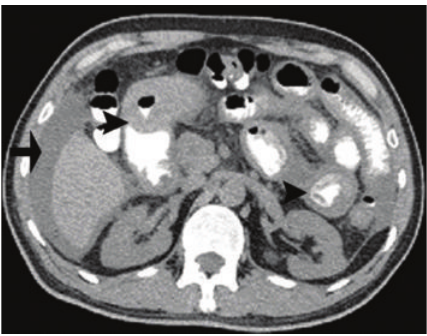
Figure 2: This high-power oil immersion view of the peripheral blood shows two eosinophils. In addition, a lymphocyte is present as well as abundant background of red blood cells (Wright-Giemsa stain; magnification 1000 × ).